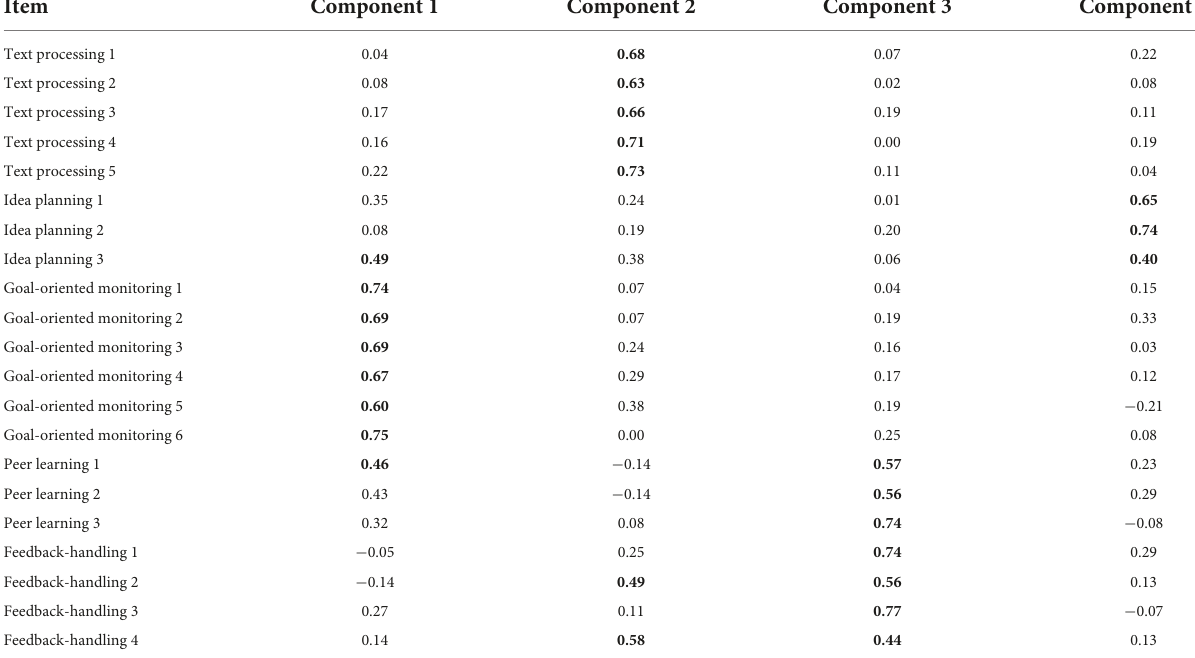
TABLE 3 Principal component analysis factor loadings for self-regulated writing